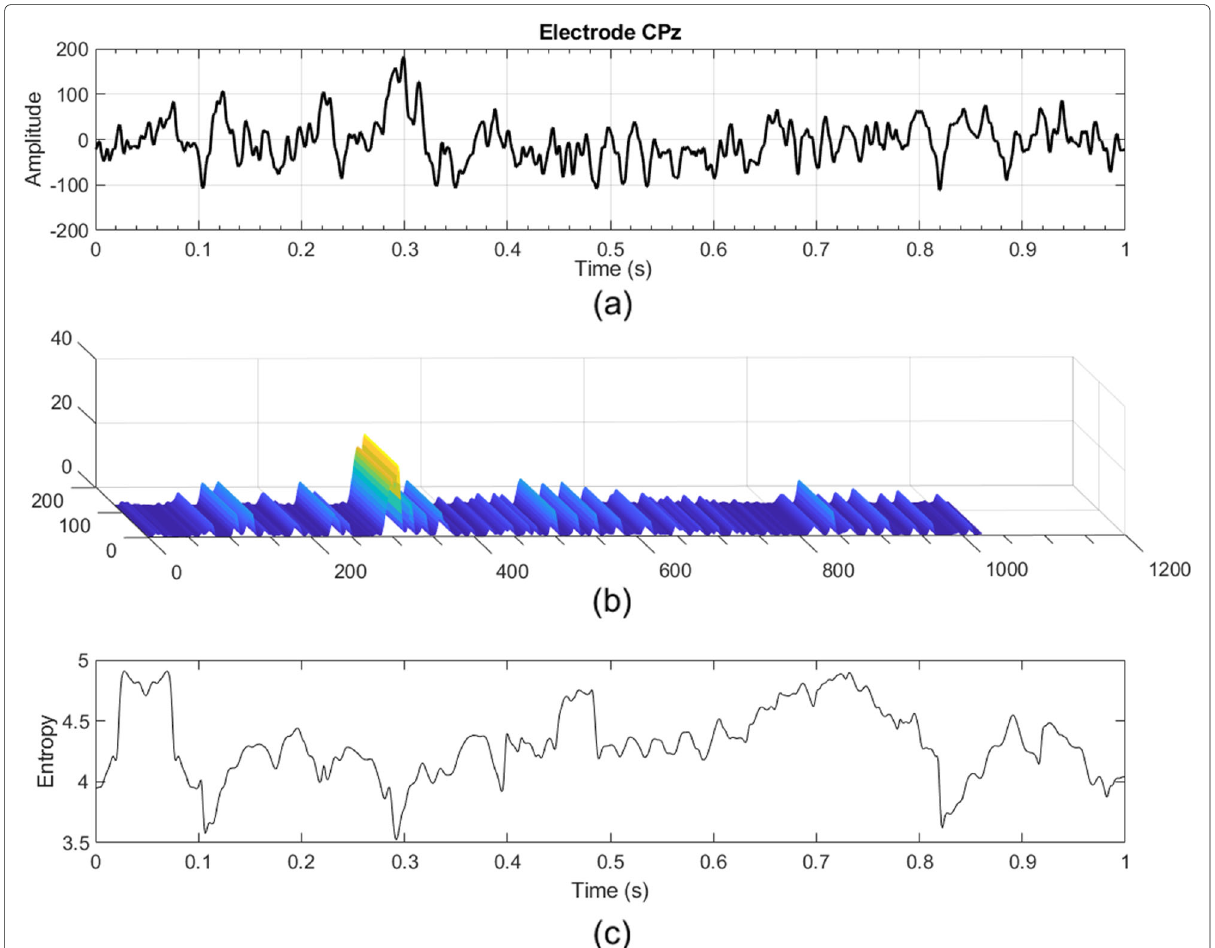
Fig. 6 Electrode CPz a . Time domain representation of ERP. b SPWVD time-frequency representation. c Short-term Rényi entropy of the